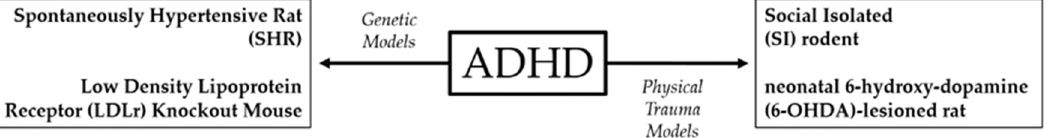
Figure 1. Animal models of Attention Deficit Hyperactivity Disorder. Key for abbreviations used: SHR: spontaneously hypertensive rat, low-density lipoprotein receptor, SI: social isolated, 6-OHDA: 6-hydroxy-dopamine, ADHD: Attention Deficit Hyperactivity Disorder.